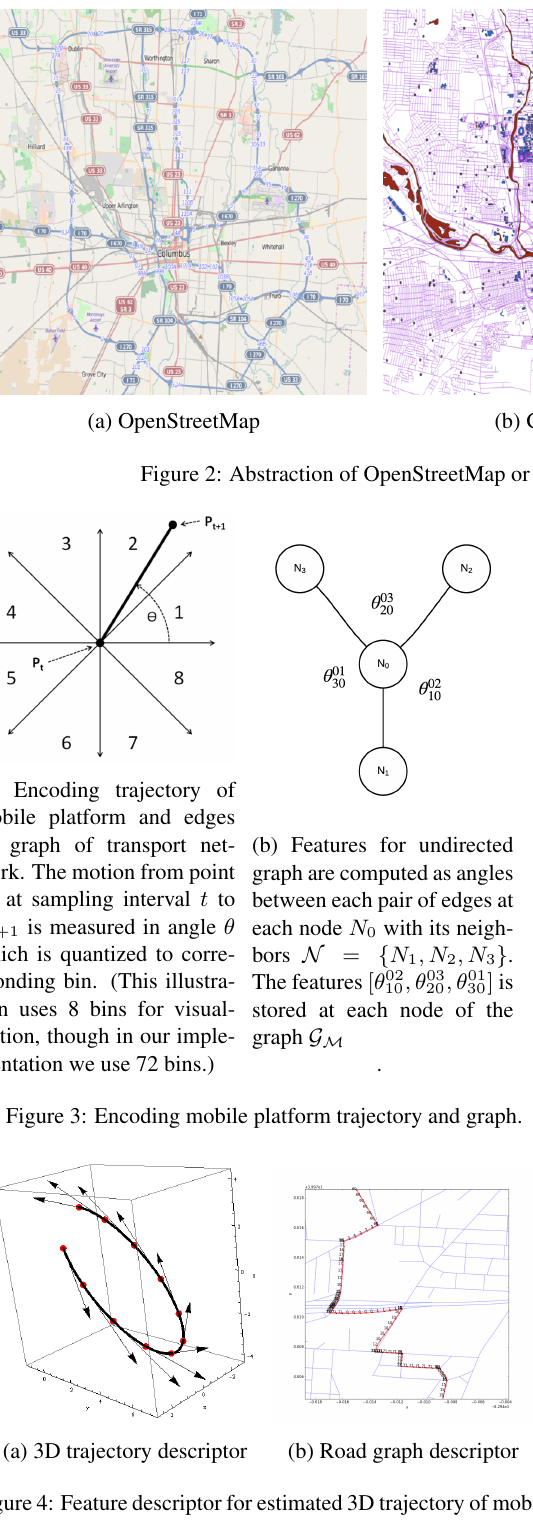
Figure 4: Feature descriptor for estimated 3D trajectory of mobile platform and edges of graph representing roads. The descriptor is computationally efficient and facilitates matching between the trajectory of the mobile platform and the transport network graph.